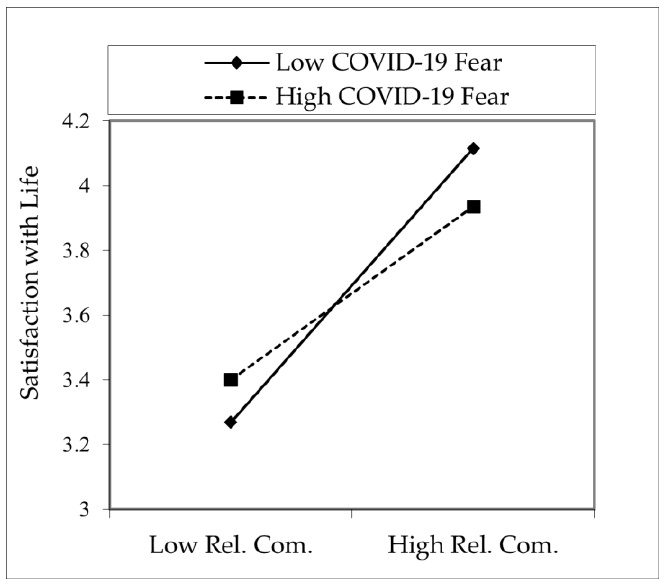
Figure 2. COVID-19 fear and religious commitment interaction effect on satisfaction with life.